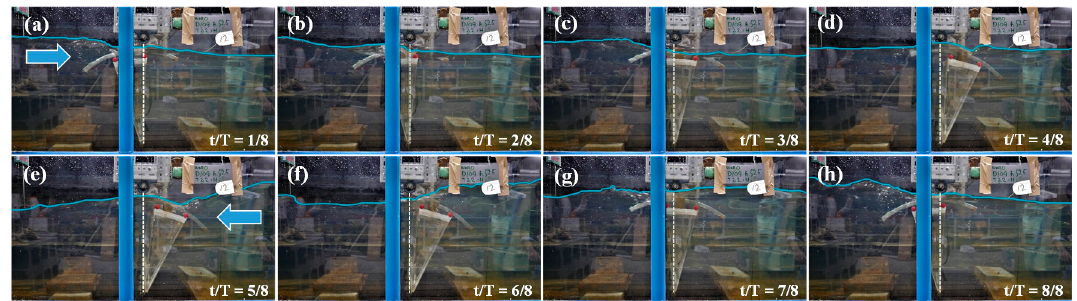
Figure 21. Screenshots of the flap motions for the case of D = 1.09 m, h = 0.525 m, T = 2.2 s, and H i = 0.12 m at ( a ) t / T = 1 / 8 to ( h ) 8 / 8. D / L is 0.2355 and k e = 0.18. The blue arrow denotes the wave direction acting on the flap, and the white dotted line indicates the rotational neutral axis of the flap. The blue solid line denotes the water surface.